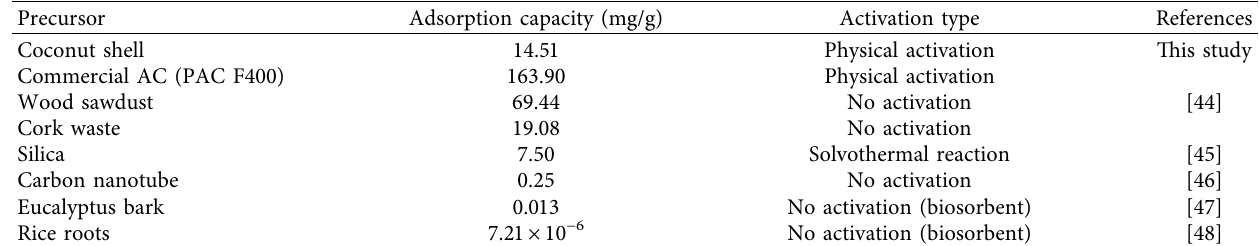
Table 7: Comparison of DDT adsorption capacity by different types of adsorbents.